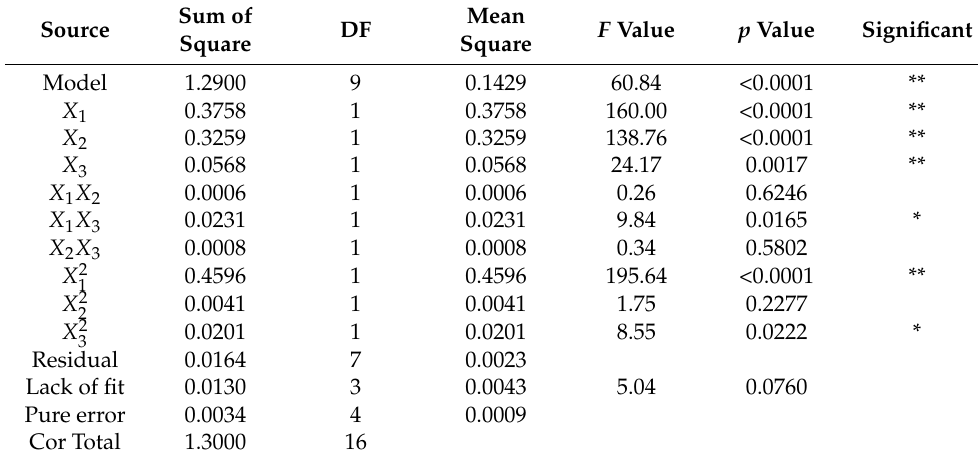
Table 3. Variance analysis of response surface quadratic